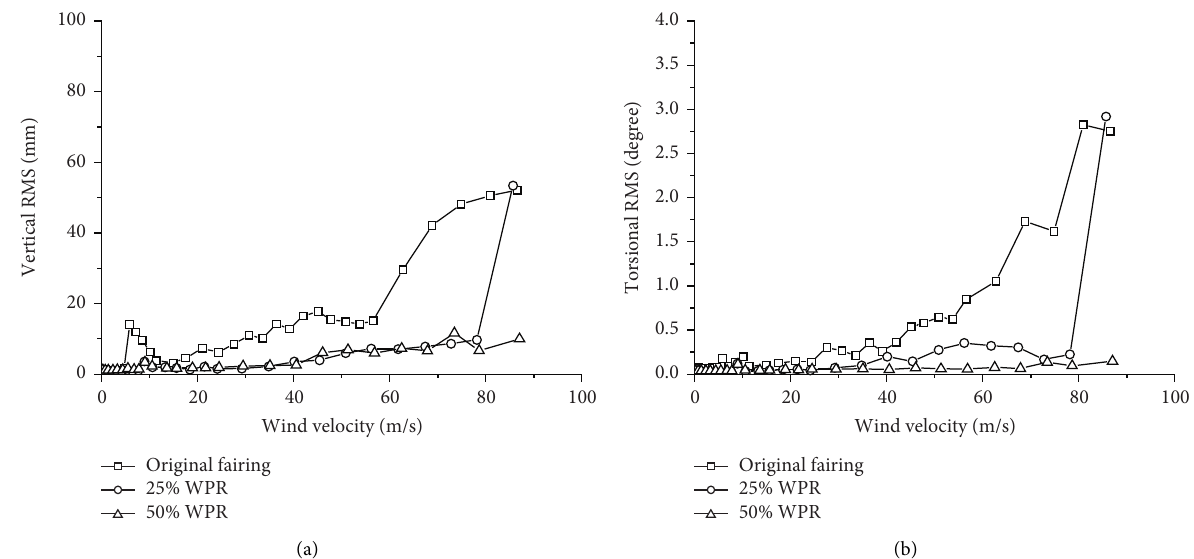
Figure 15: RMS versus wind velocity in laminar flow (attack angle 3 ° ): (a) vertical RMS; (b) torsional RMS.